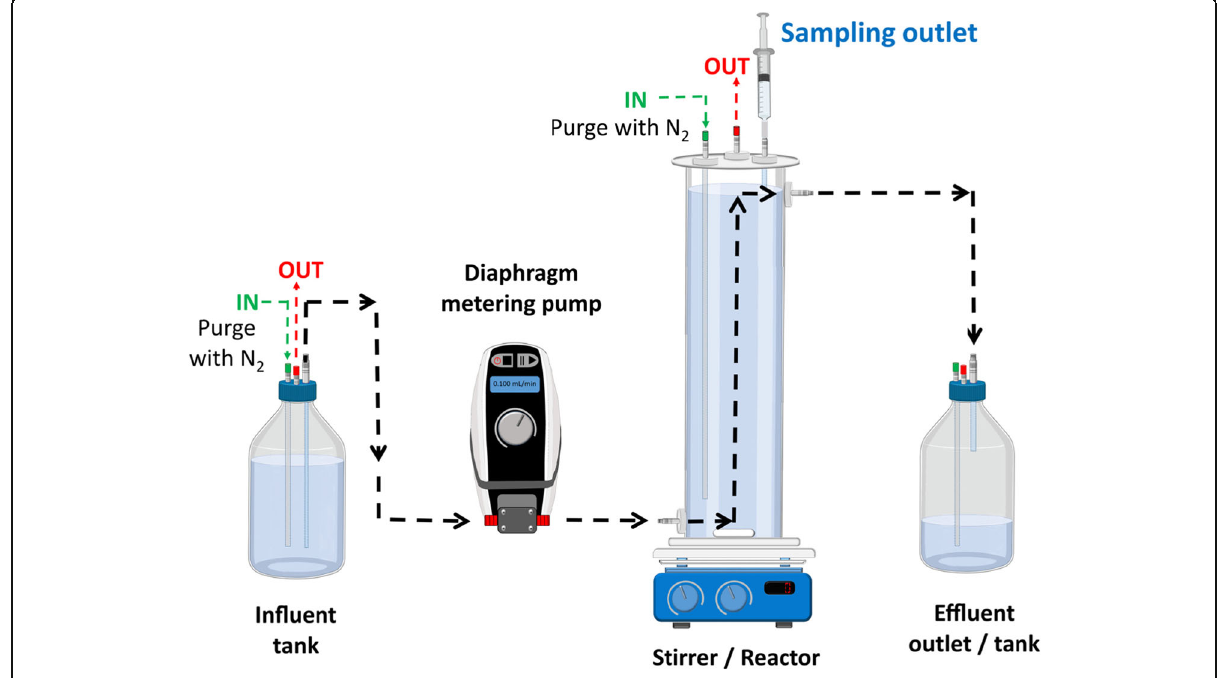
Fig. 1 Experimental set-up of the laboratorial upflow reactor